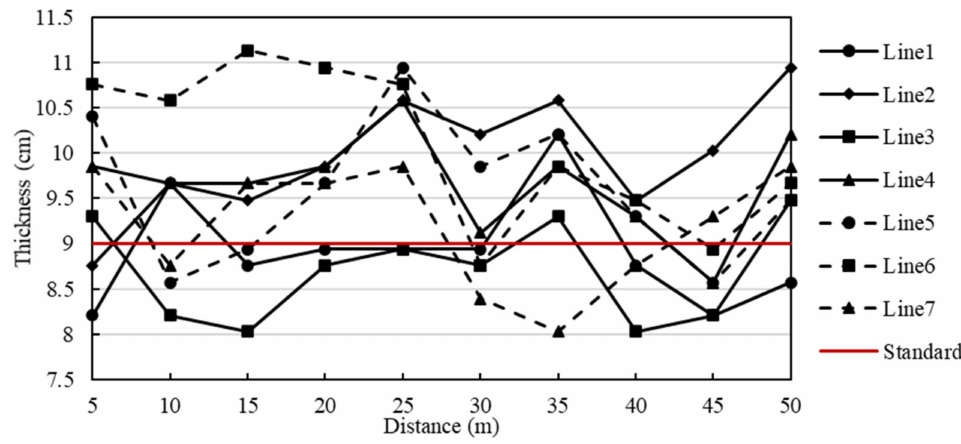
Figure 7. Mean values of thickness in 70 evaluated areas. Figure 8 is the thickness coefficient of variation of the test area. The mean coefficient of variation in Line 4 was 0.073 and showed the best thickness